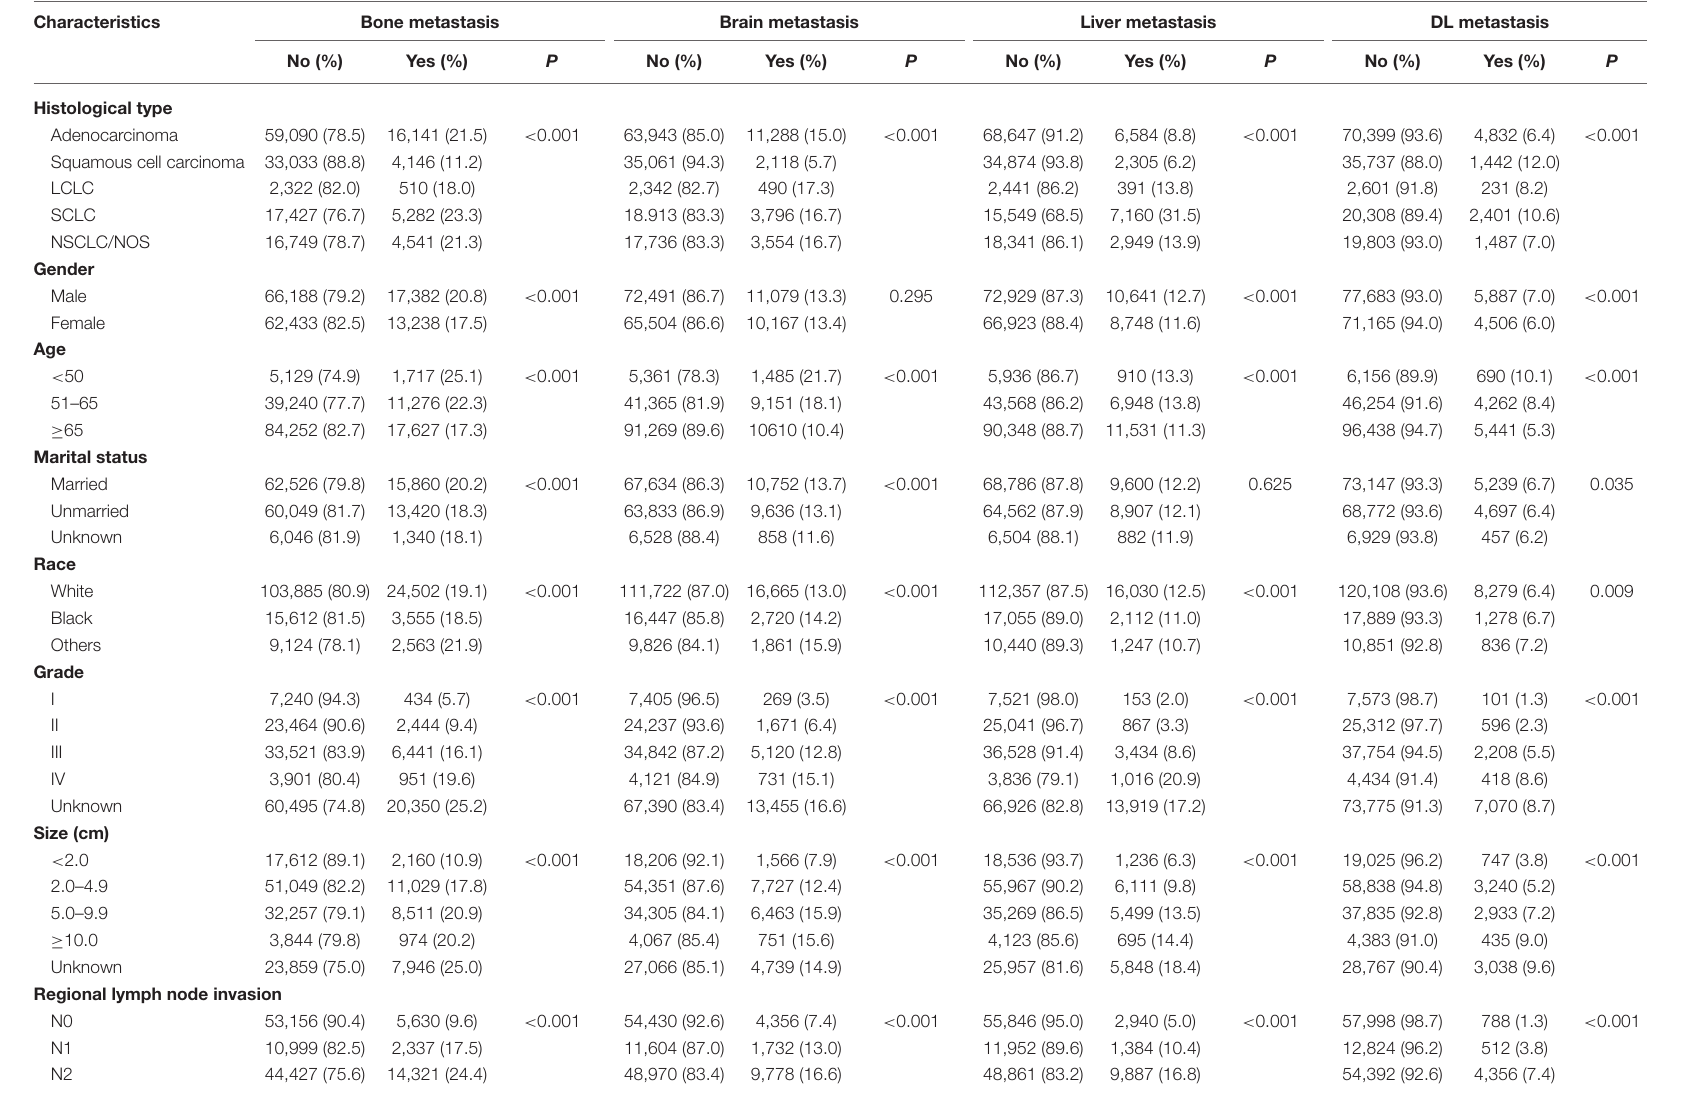
TABLE 1 | Baseline clinical characteristics of lung cancer patients in SEER